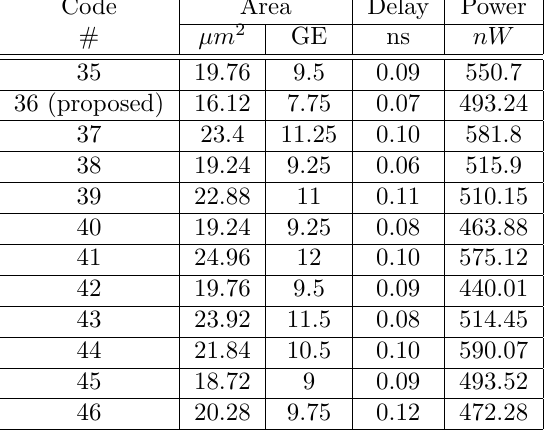
Table 14: Synthesis results of different formulations for one bit of the subfield inverter. Code